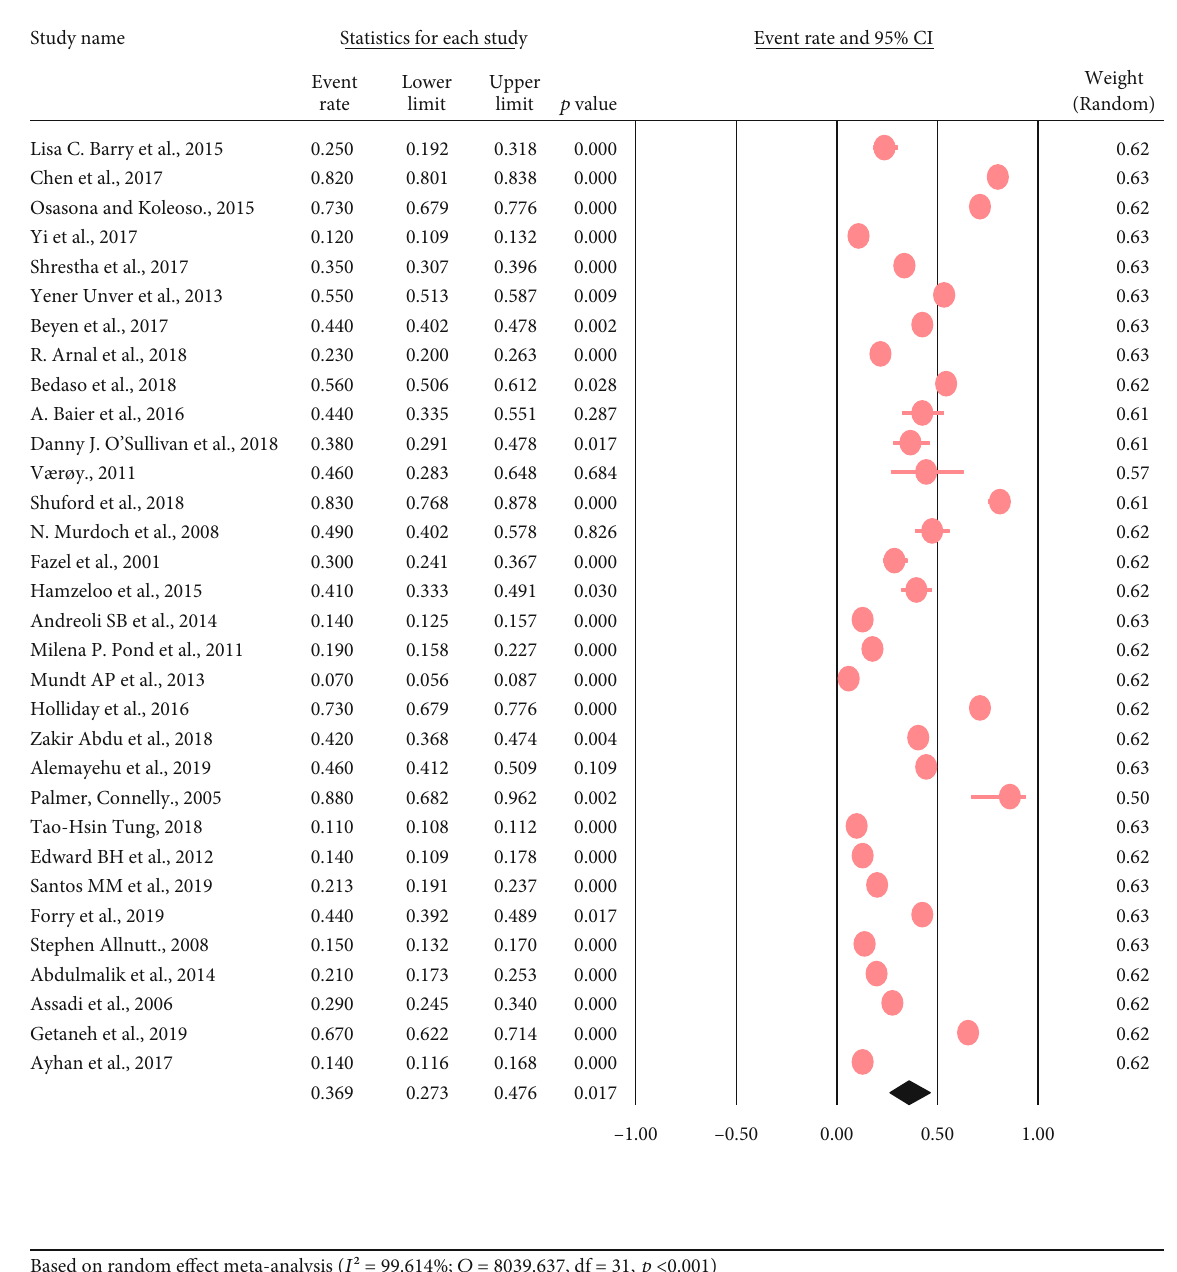
Figure 2: Forest plot for the prevalence of depression among prisoners : a